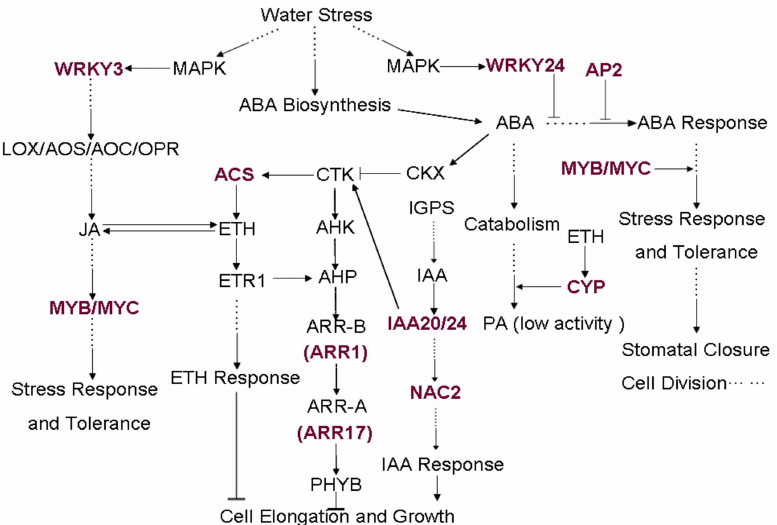
Figure 5. Gene net correlated to JA, ABA and other hormone biosynthetic, signaling and response pathway under water stress. The key elements of pathway are displayed in web-like network and are connected by arrows. A previously established link among IAA, ABA, Ethylene, CTK and cell elongation and growth is indicated. The red and overstriking words represent di ff erentially expressed genes induced by COR in microarray. Arrows and t-bars represent positive and negative e ff ects, respectively. Solid lines indicate e ff ects that occur through direct interaction, whereas dotted lines indicate e ff ects that have not yet been shown to occur through direct